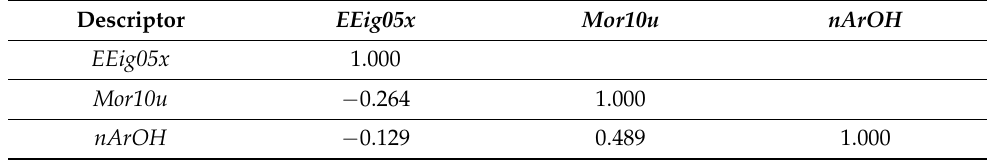
Table 3. Correlation matrix (with correlation coefficient values R ) for descriptors used in Equation